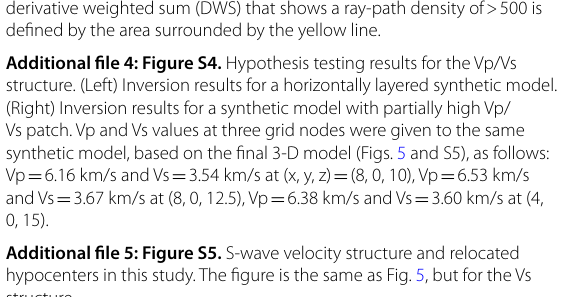
Additional file 3: Figure S3. Checkerboard test results for the Vp (left) and Vs (right) structure in the vertical cross-sections at y -4, 0, 4 km. The = derivative weighted sum (DWS) that shows a ray-path density of > 500 is defined by the area surrounded by the yellow line. Additional file 4: Figure S4. Hypothesis testing results for the Vp/Vs structure. (Left) Inversion results for a horizontally layered synthetic model. (Right) Inversion results for a synthetic model with partially high Vp/ Vs patch. Vp and Vs values at three grid nodes were given to the same synthetic model, based on the final 3-D model (Figs. 5 and S5), as follows: Vp 6.16 km/s and Vs 3.54 km/s at (x, y, z) (8, 0, 10), Vp 6.53 km/s = = = = and Vs 3.67 km/s at (8, 0, 12.5), Vp 6.38 km/s and Vs 3.60 km/s at (4, = = = 0, 15). Additional file 5: Figure S5. S-wave velocity structure and relocated hypocenters in this study. The figure is the same as Fig. 5, but for the Vs